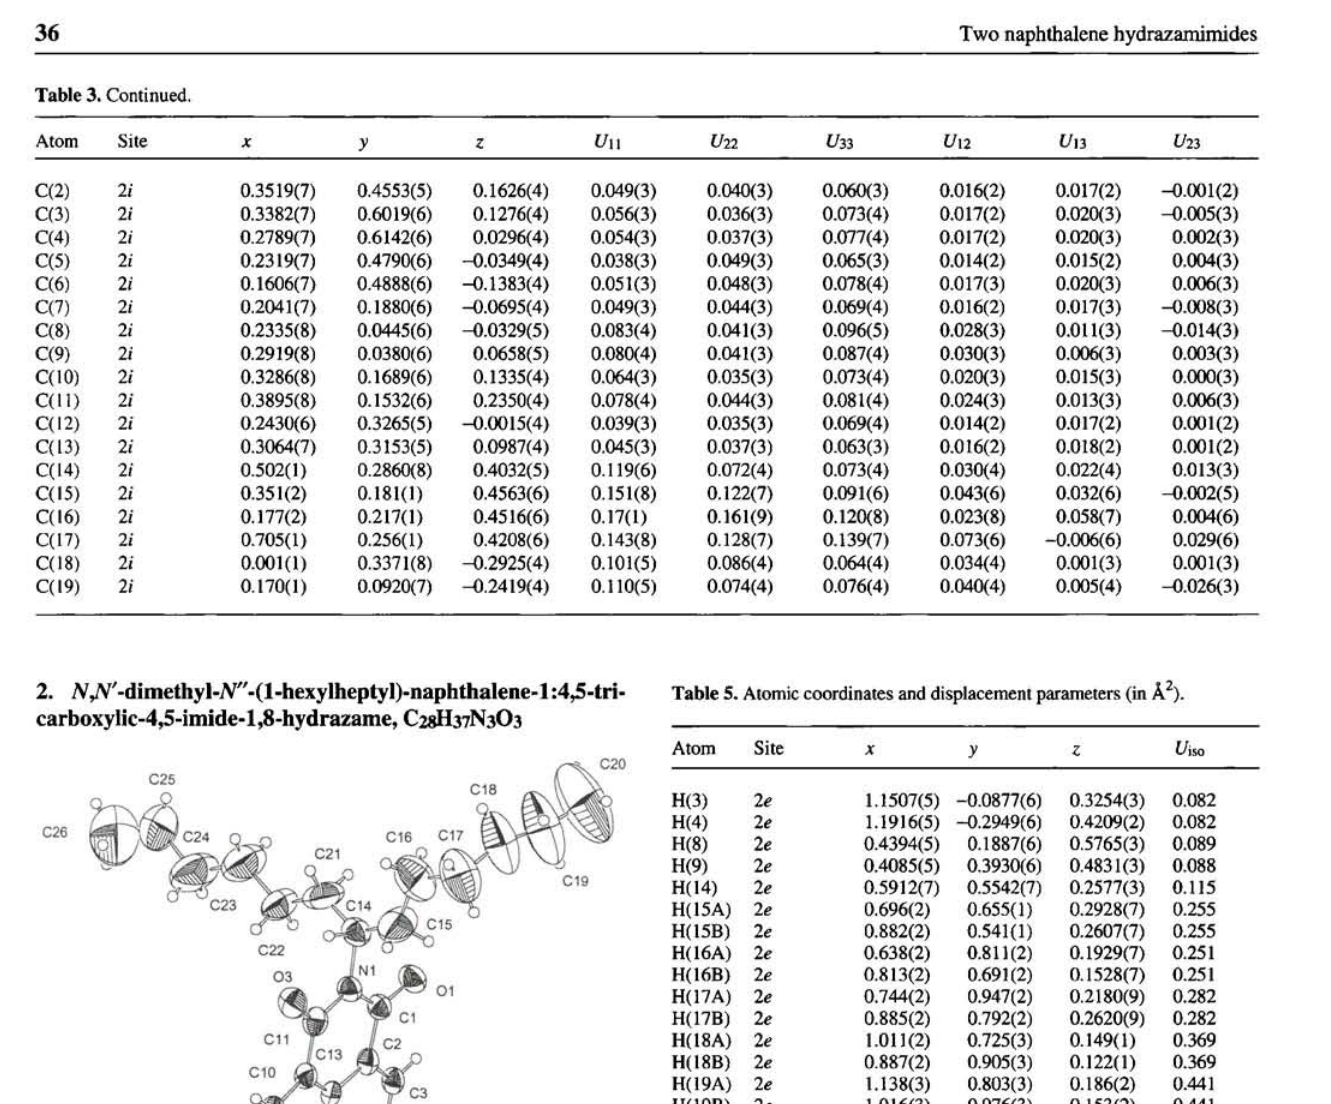
Table 4. Data collection and